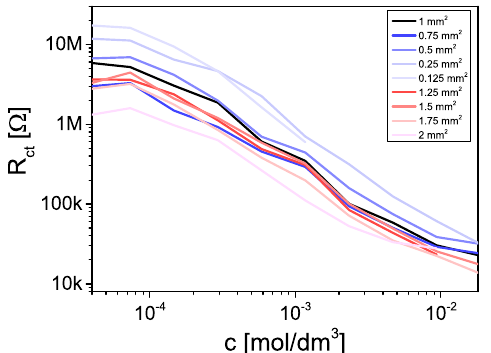
Figure 9. Charge transfer resistance as a function of the concentration of Fe 2 + /3 + ions for integrated electrochemical